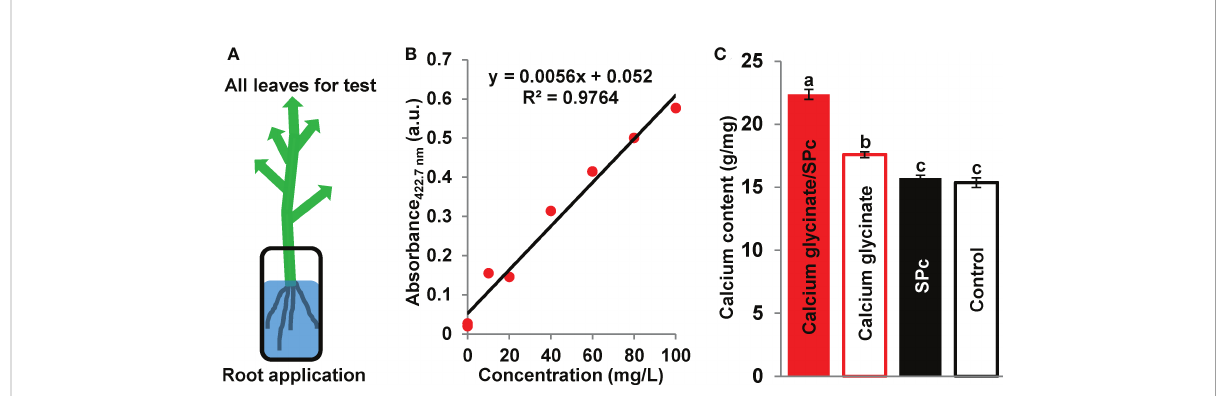
FIGURE 4 Enhanced transport of SPc-loaded calcium glycinate. (A) Schematic diagram. Tomato seedlings were cultured in the solutions of calcium glycinate and calcium glycinate/SPc complex for 24 h. All leaves were collected, dried and homogenized for calcium content measurement. (B) Standard calibration curve of calcium. (C) Calcium content in leaves. Each treatment included 3 independent samples. Different letters indicate signi fi cant differences according to Tukey HSD test ( P < 0.05).